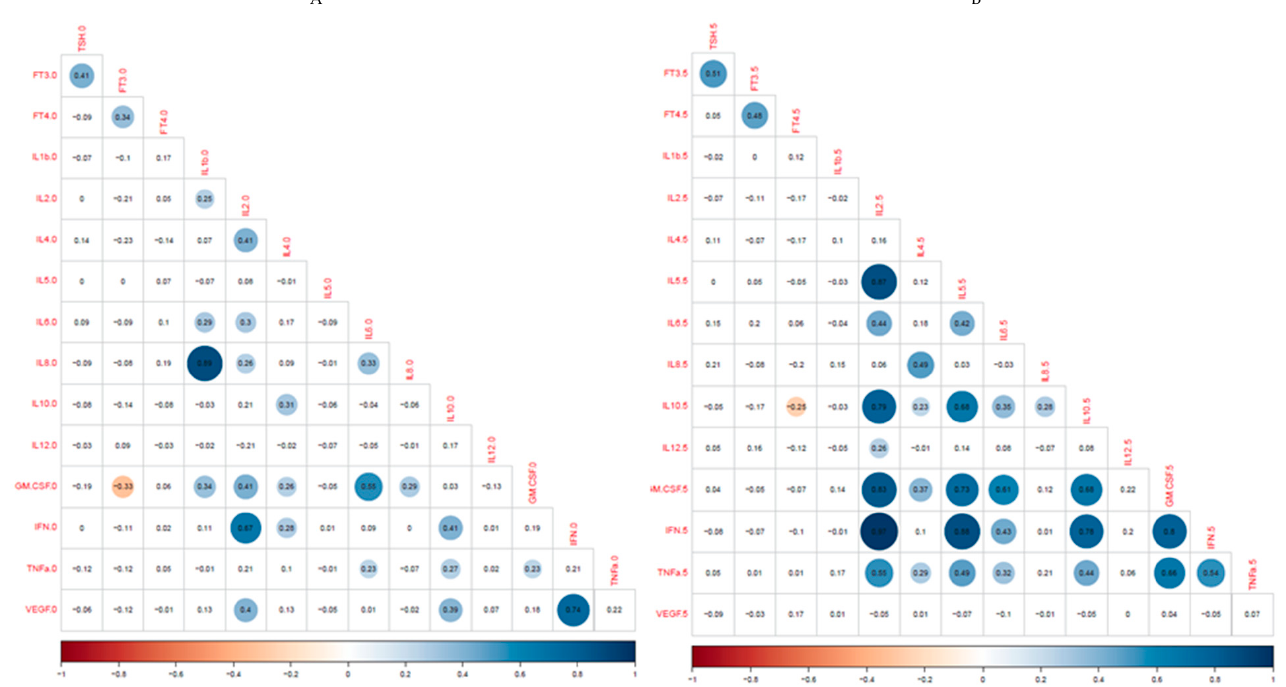
Figure 1. Heat map showing the associations of the thyroid hormones and cytokines evaluated at ICU admission ( A ) and day 5 ( B ). Pearson correlation coefficients are displayed. Circles representing the strength of correlation are omitted if they do not achieve statistical significance. Blue and red circles represent positive and negative correlations.